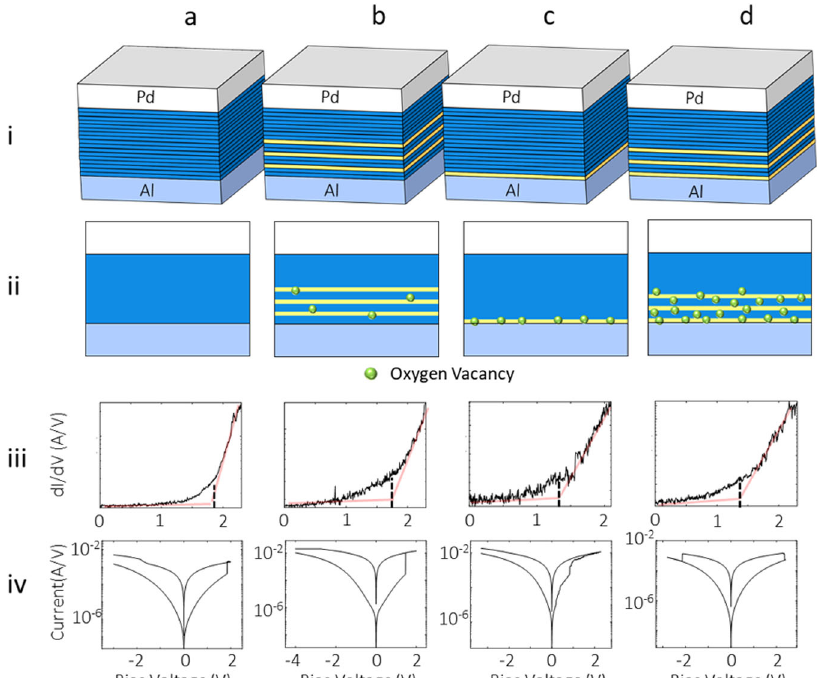
Fig. 3 Design of atomically tuned memristors. In row i, diagrams of atomic layer deposition memristor makeups totaling 17 atomic layers (17 C) in M1(oxide)/M2(defective oxide) stacks are shown. These memristors are comprised of: a 17 Al 2 O 3 atomic layers, b 3 MgO atomic layers in the M1 at the 3rd, 6th, and 9th position from Al electrode at the bottom, c one MgO layer as the M2 layer in the 1st position above Al electrode, and d 3 MgO layers at the 1st, 4th, and 7th position, with the fi rst one serving as the M2. In row ii, diagrams of the expected vacancy distribution in a – d are shown. In row iii, representative scanning tunneling spectroscopy d I/ d V curves are shown in log scale to demonstrate local density of states in the a – d samples. In row iv characteristic memristor I – V curves of each device in a – d are displayed showing either early failure or consistent